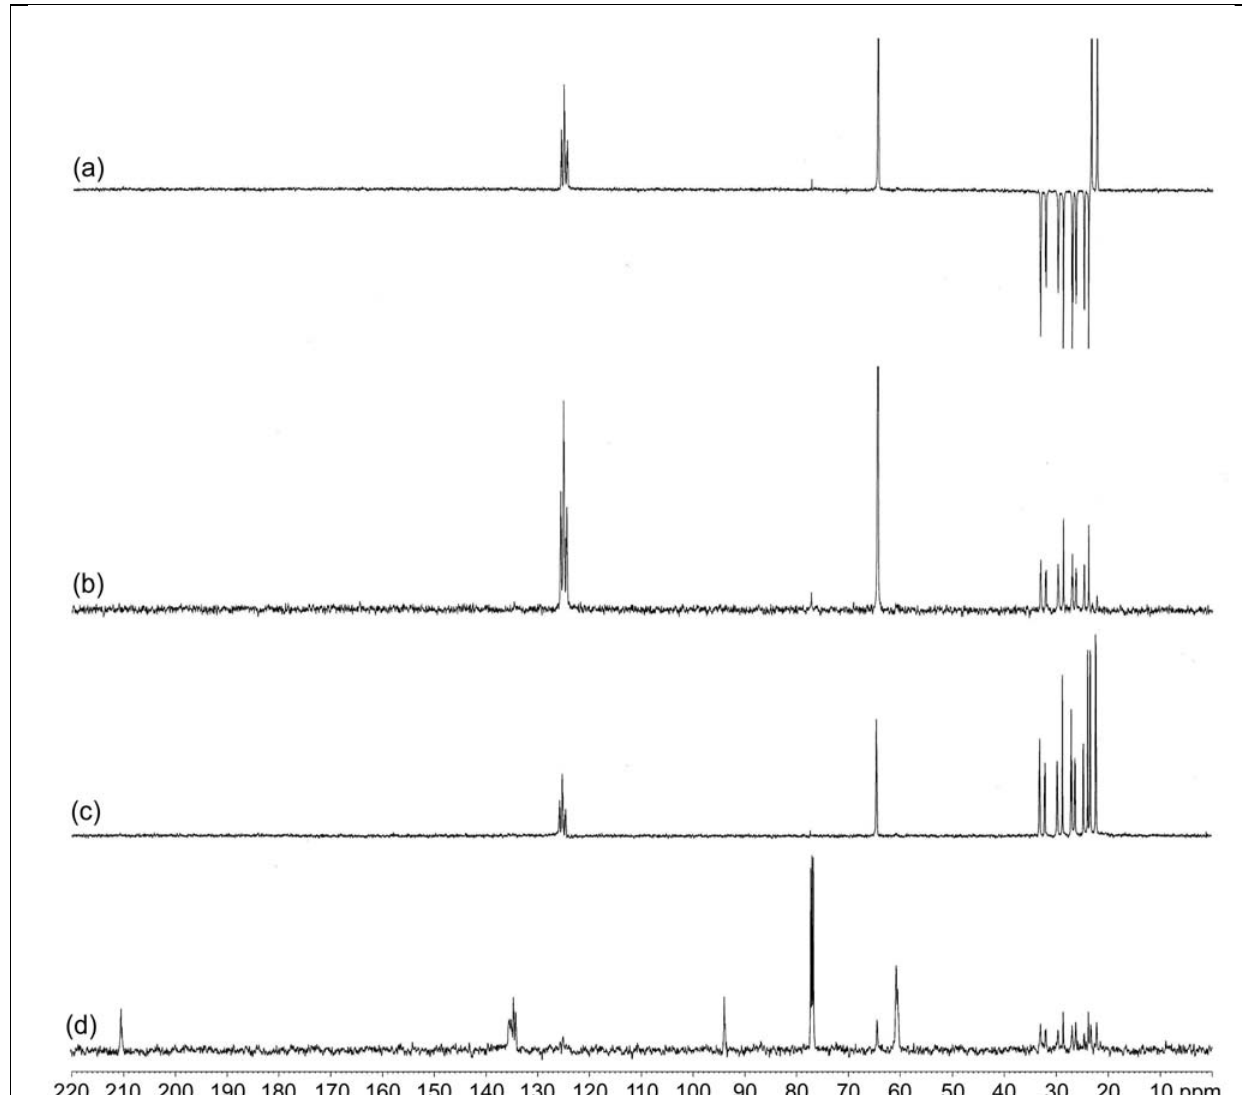
Figure 9. ( a ) DEPT-135; ( b ) DEPT-90; ( c ) DEPT-45 and ( d ) DEPT quartenary spectra of cyclic dithiocarbonate derivative of ENR-50 (in CDCl